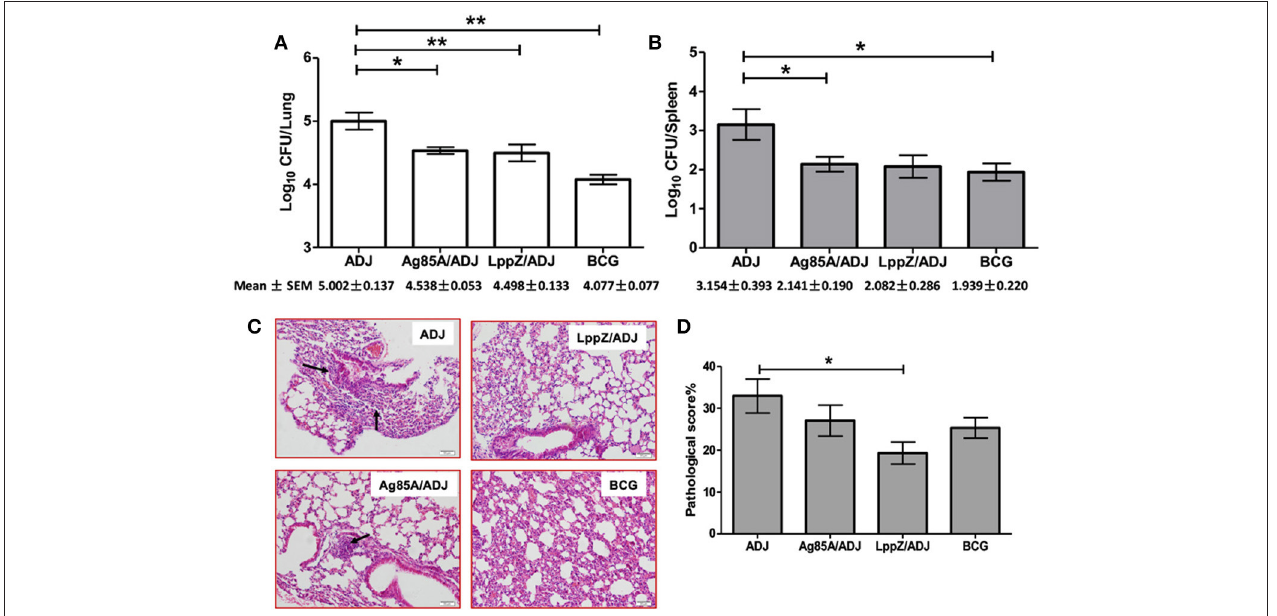
FIGURE 5 | Bacteria load and lung histopathology after aerosol infection with virulent H37Rv strain. Six C57BL/6 female mice were immunized with purified Ag85A (Ag85A/ADJ) or LppZ (LppZ/ADJ) recombinant protein emulsified with adjuvant. Adjuvant only (ADJ) and BCG (BCG) immunization were used as controls. Four weeks after the last immunization, mice were challenged with the virulent M.tb strain H37Rv. Bacteria load in the lungs (A) and spleens (B) were enumerated and represented as the mean log